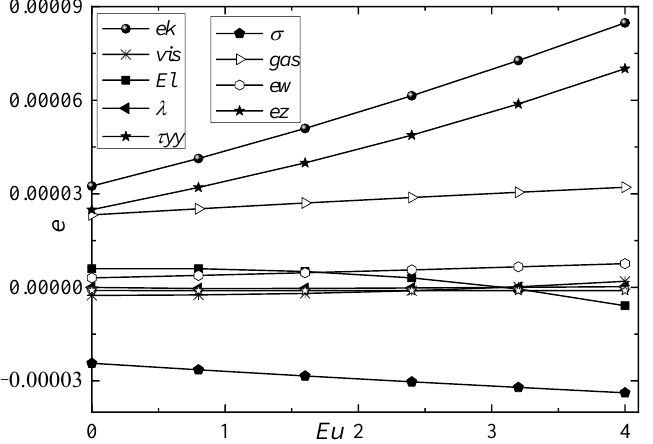
Figure 12. Effect of electrical Euler number E u on rate of change in kinetic energy and other forces.